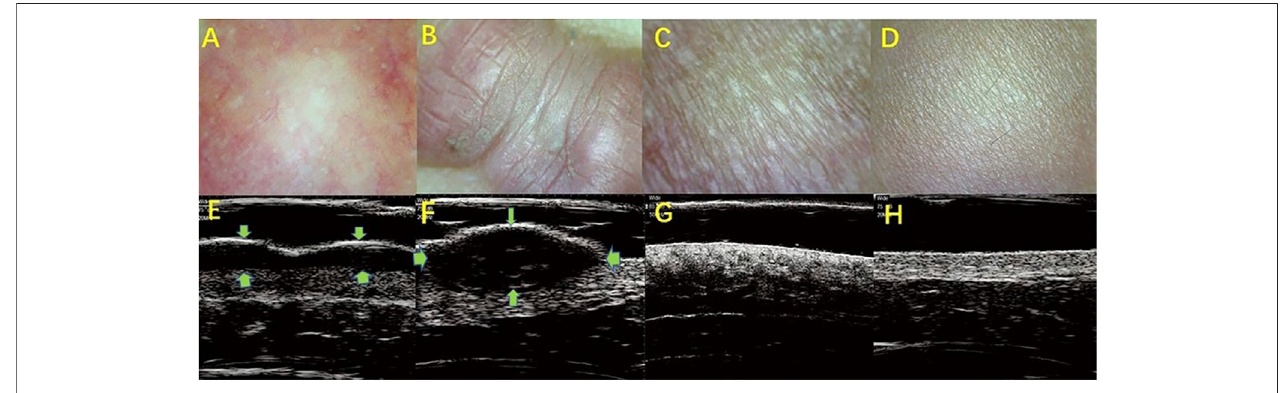
FIGURE1| HFUSidentifyingthedifferenttypesofskinscars. (A,E) :Hypertroplicscars; (B,F) :Keloids; (C,G) :Atrophicscars; (D,H) :Normalskin. (A – D) :Theoptical characteristics of various scars observed by skin microscopy; (E – H) : audio-visual characteristics of scar skin detected by 20 MHz HFUS.